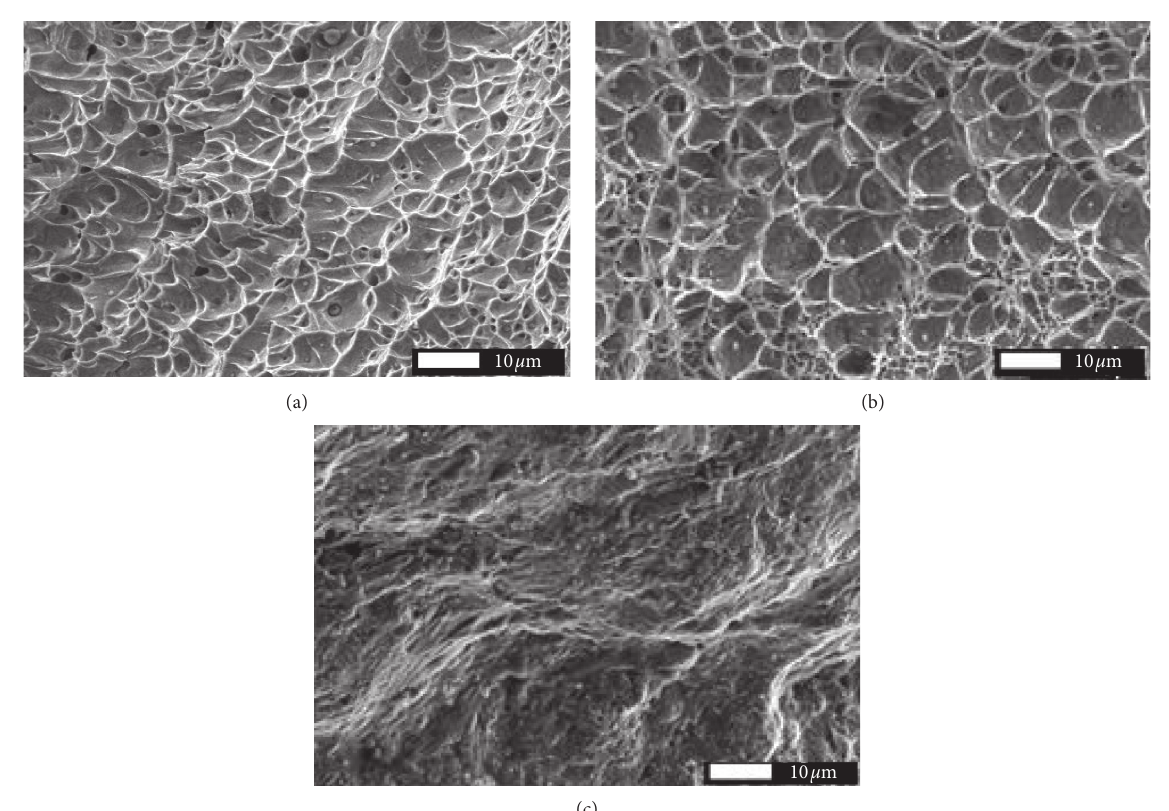
Figure 9: Fractograph of duplex stainless steel 2205 impact charpy “ V ” notch in TIG and ATIG in welded zone. (a) ATIG 1 FZ (500 × ). (b) ATIG 2 FZ (500 × ). (c) ATIG 3 FZ (500 × ).